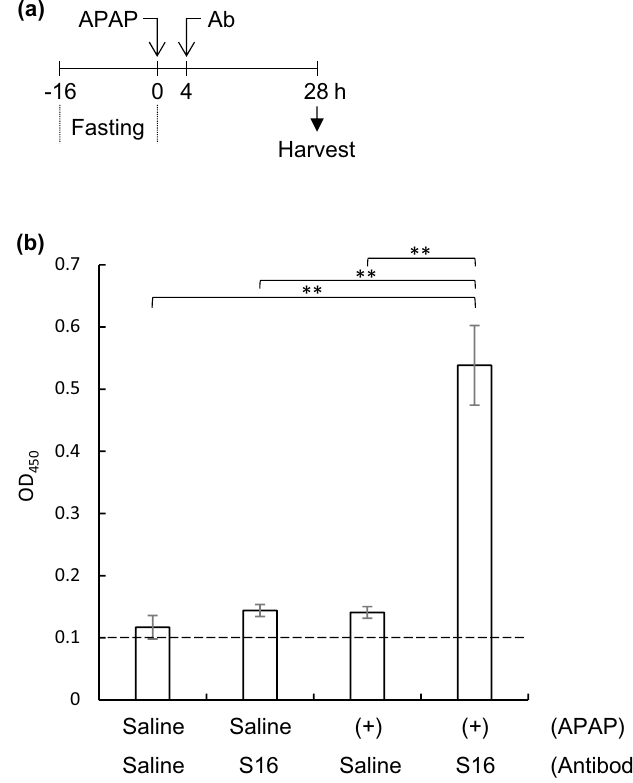
Figure 7. Complex formation between S16 and serum ACAA2. ( a ) Schematic diagram of the experiment. BALB/c mice (n = 6, in each group) were fasted for 16 h. At 0 h, the mice were intraperitoneally administered saline or APAP (300 mg/kg). At 4 h, the mice were injected intraperitoneally with saline or S16 (100 μg), and then sacrificed at 28 h. ( b ) Serum was collected from mice after 28 h of APAP administration, and complexes of S16 with ACAA2 in each serum sample were determined using sandwich ELISA. The values represent the mean ± SD from three independent experiments. Significant differences between groups are indicated using asterisks (** p < 0.01). The dotted line (OD 450 = 0.1) indicates the detection